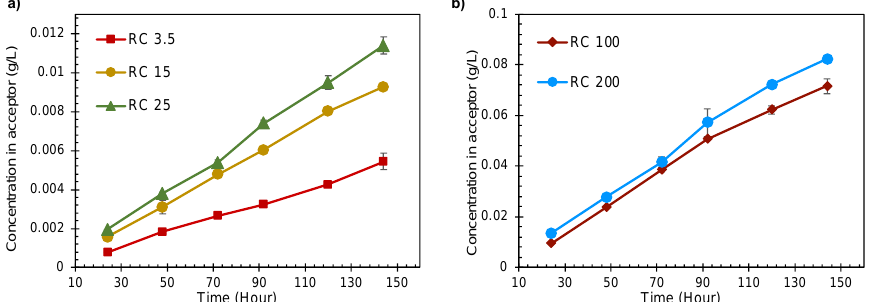
Figure 1. Concentration of lignin in the acceptor chamber versus time through different membranes. ( a ) RC3.5, RC15 and RC25; ( b ) RC100 and RC200. As expected, there is an increase in the diffusion rate with increasing pore size. The transport rates of lignin samples passing through the membranes with the largest pore sizes (RC100 and RC200) were about 10 times greater than for the smallest. The diffusivity calculated for lignin over RC200 and RC3.5 were 39 × 10 − 14 and 3.8 × 10 − 14 m 2 s − 1 , respectively (see Table S1 in Supporting Information). The reduced transport rate can be explained by the fact that large lignin molecules (with a larger hydrodynamic radius) and/or lignin clusters are maybe unable to enter and pass through the pores of smaller size, whilst small molecules can. This was verified by using SEC to determine the molecular size distribution (Figure 2).